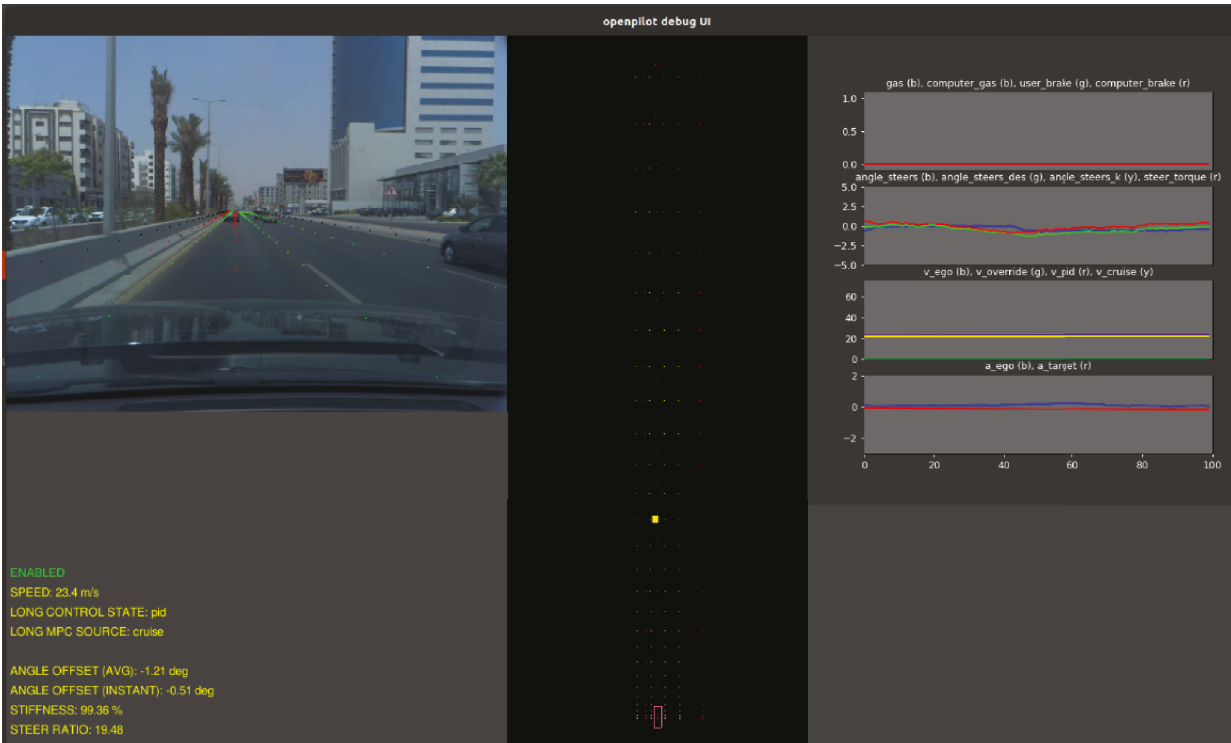
Figure 39: OP debugging